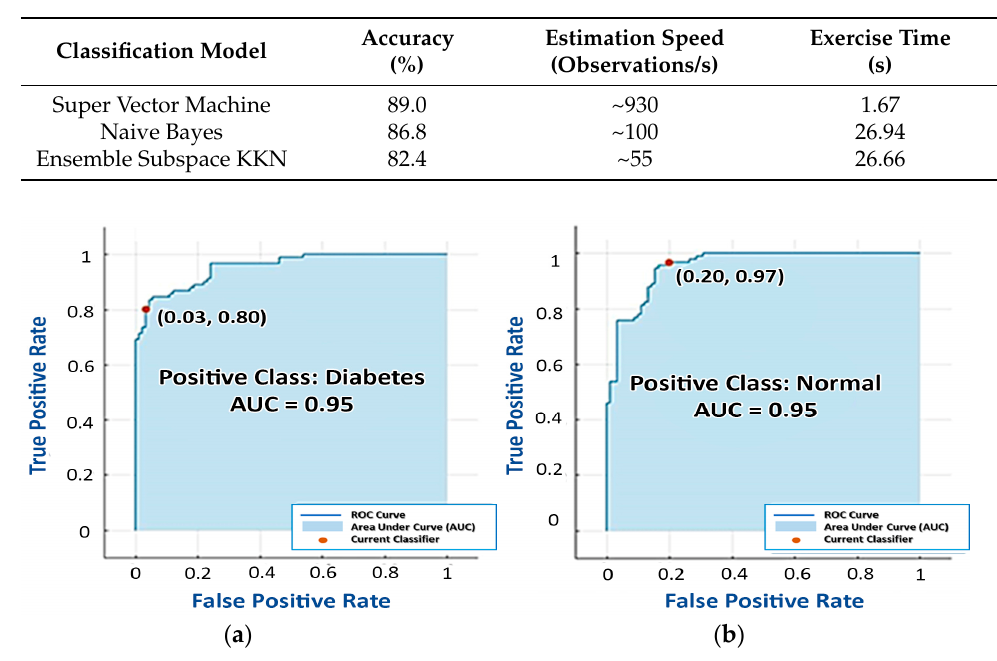
Figure 14. ( a ) Positive-class diabetes ROC curve; ( b ) positive-class normal ROC curve. Table 5. Classification performance of super vector machine classifier.